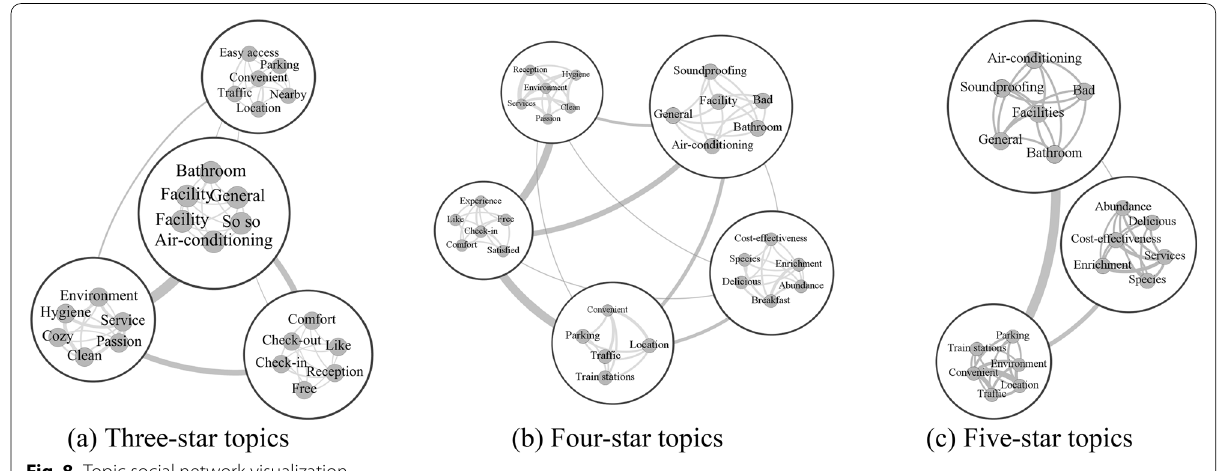
Fig. 8 Topic social network